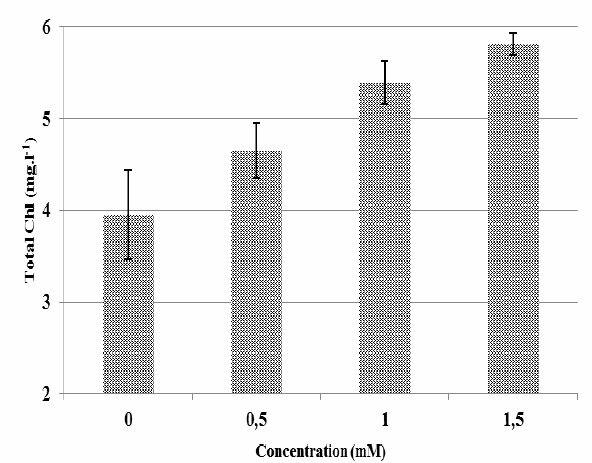
Fig. 4. Effect of different concentrations of SA on total